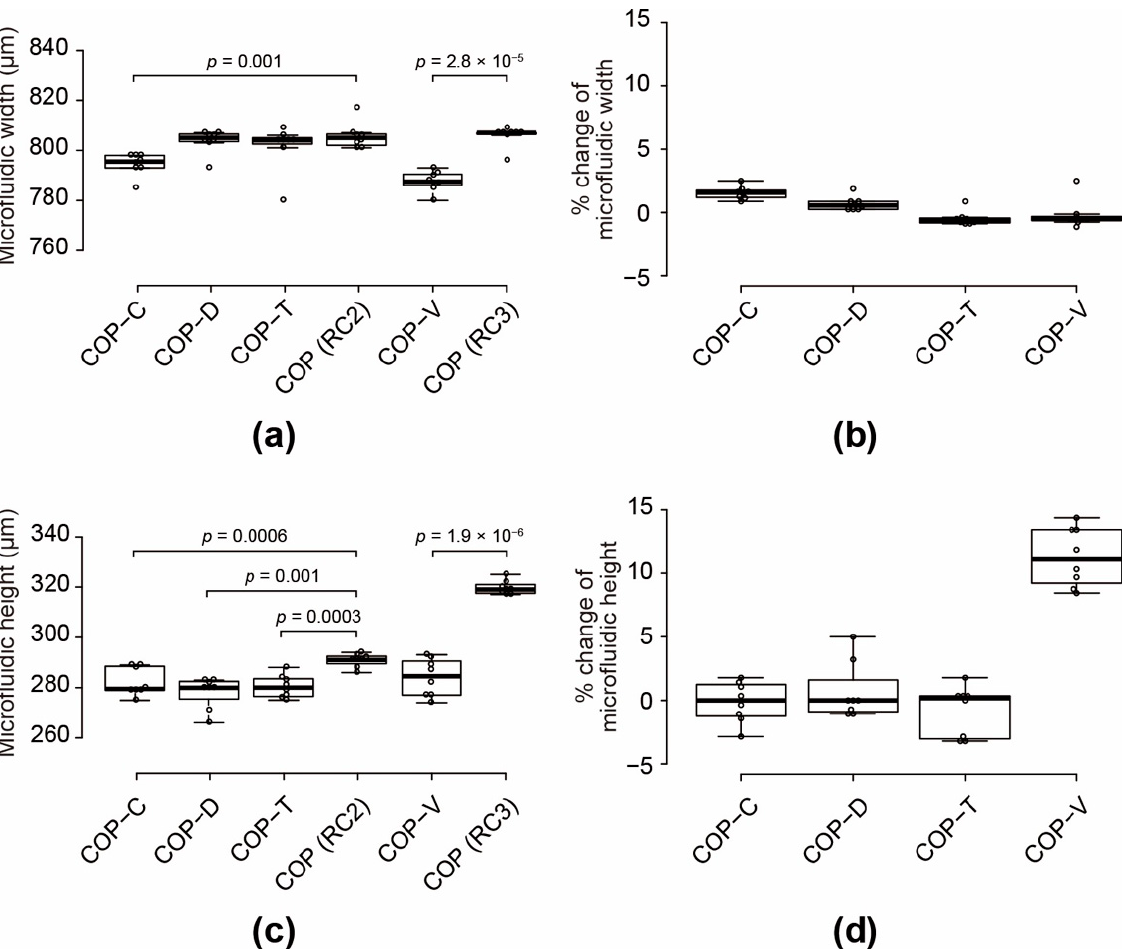
Figure 3. Variations in the width and height of cyclo-olefin polymer (COP) microfluidic channels: ( a , c ) measured widths and heights, respectively, and ( b , d ) deviations of the widths and heights, respectively, relative to those of the original structures. The center lines indicate the median values; the box limits indicate the 25th and 75th percentiles; the whiskers extend to 1.5-times the interquartile range from the 25th and 75th percentiles; outliers are represented by dots; and data points are plotted as open circles. The devices were processed by solvent bonding with toluene (COP-T), cyclohexane (COP-C), or dichloromethane (COP-D); or by vacuum ultraviolet (VUV) photobonding (COP-V). RC2 and RC3 are the original structures for the solvent-bonding and VUV-photobonding processes, respectively. Eight samples of each type were